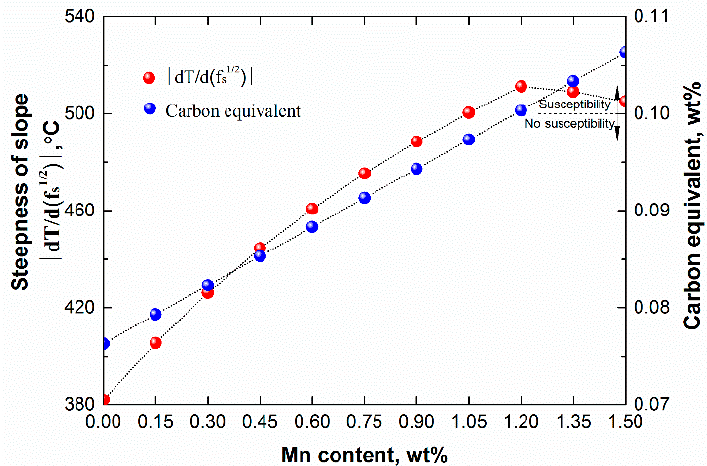
Figure 7. Comparison of the crack susceptibility of peritectic steels with different Mn contents, as well as their carbon equivalent.